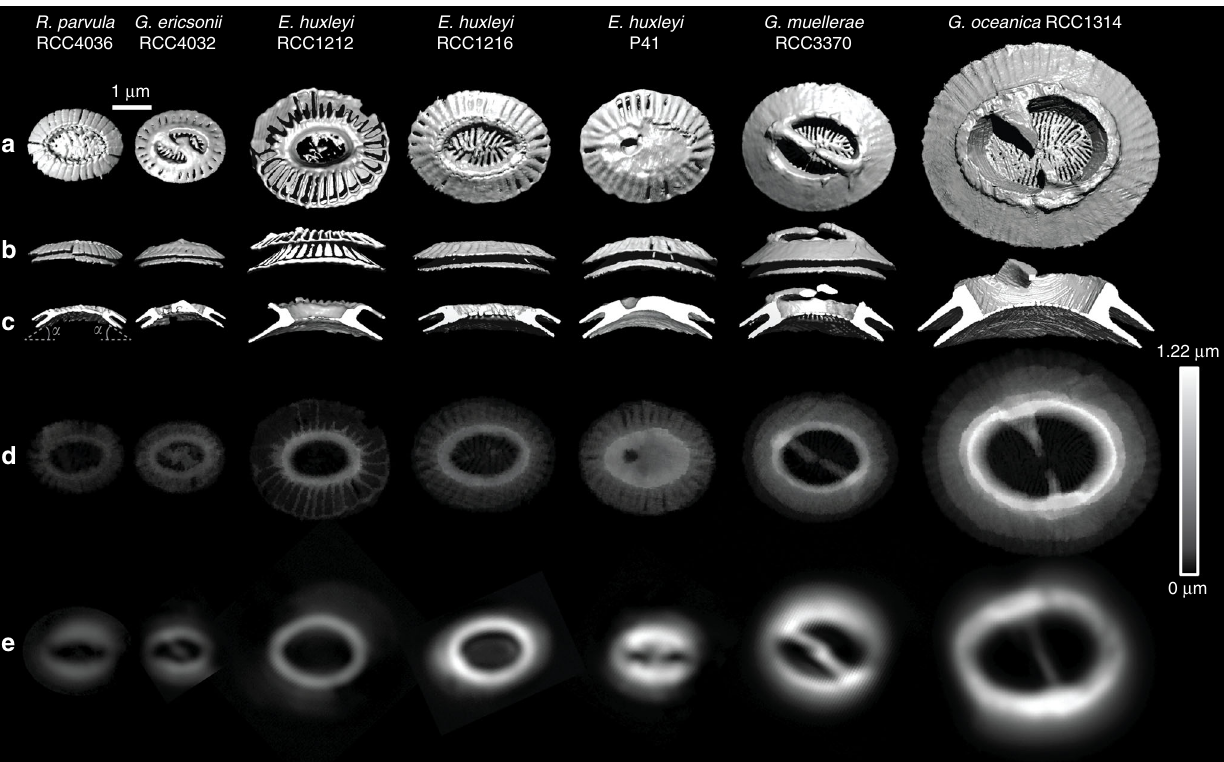
Fig. 2 3D-CXDI of coccoliths. a – c 3D-CXDI of coccoliths extracted from coccospheres and observed in: a distal view; b side view along the major axis; c side view along the major axis after sectioning half of the coccoliths. The angle α refers to the inclination of the shields. d In-plane thickness of the coccoliths resulting from the in-plane projection. e Images obtained by polarized light microscopy (PLM) displaying the distal view of coccoliths. Scale bar